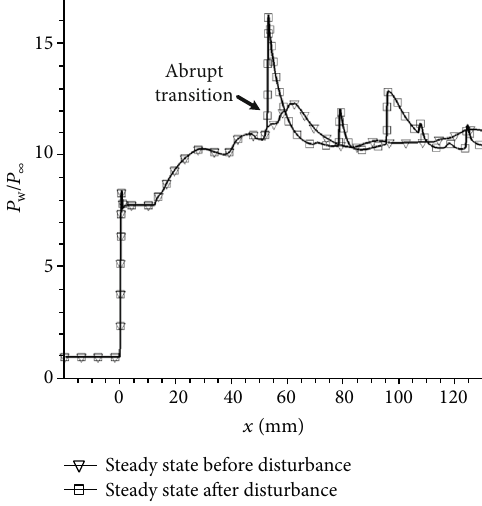
Figure 8: Pressure distributions on the bottom boundary of the steady fl ow fi elds before and after UTHD at θ = 31 ∘